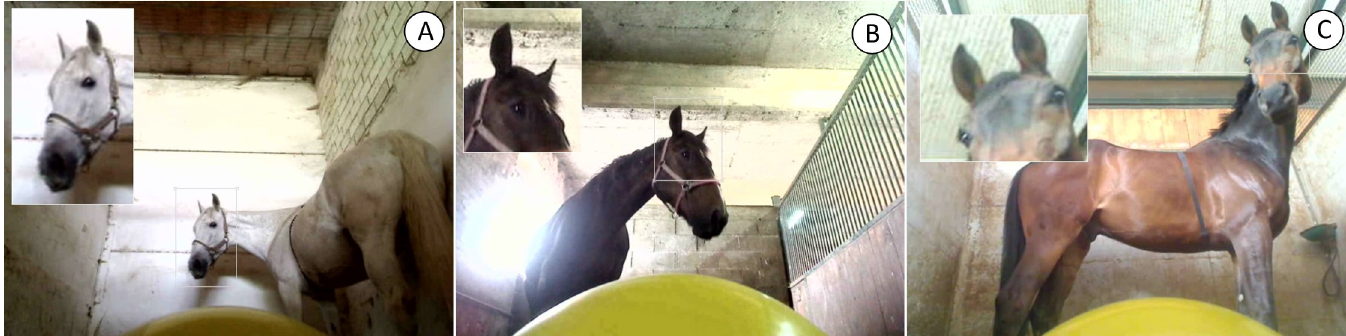
Fig 1. Example images of horses investigating the stimulus (an inflated balloon) with (A) their left eye, (B) their right eye, or (C) both eyes simultaneously, from the perspective of the stimulus.